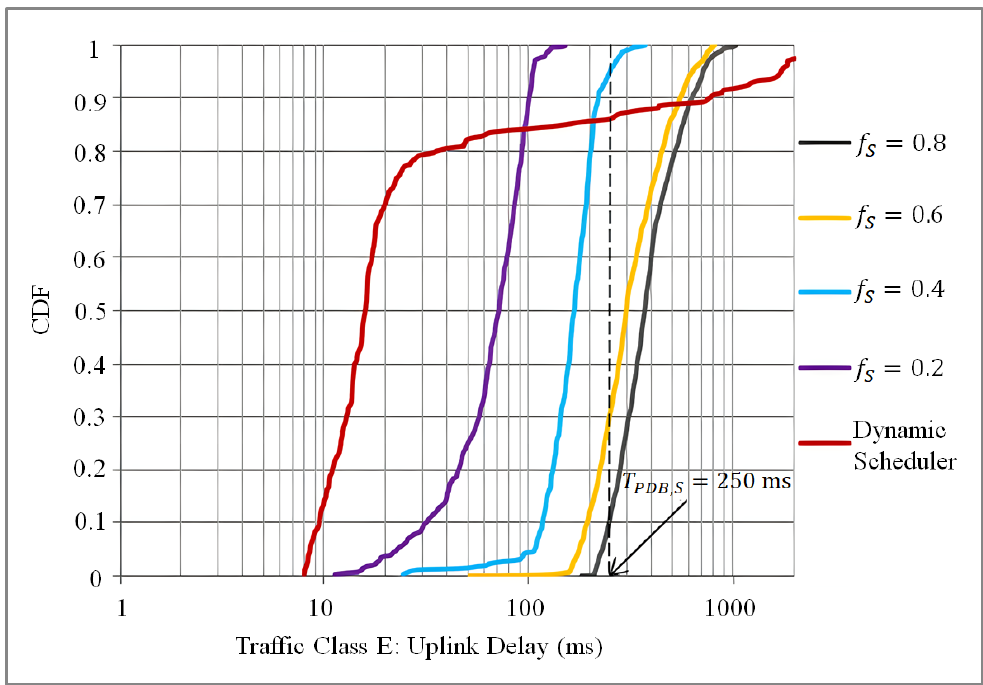
= 0.2 T PDB , S λ S